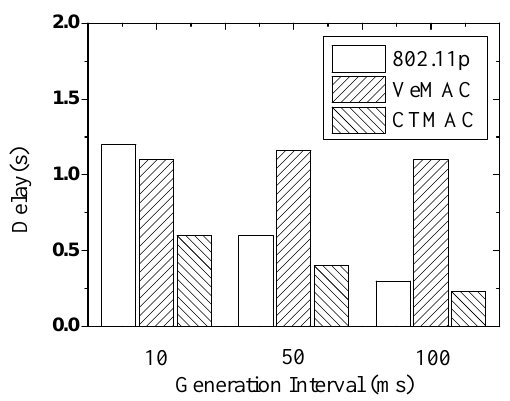
Figure 8. Online game: delay with different generation